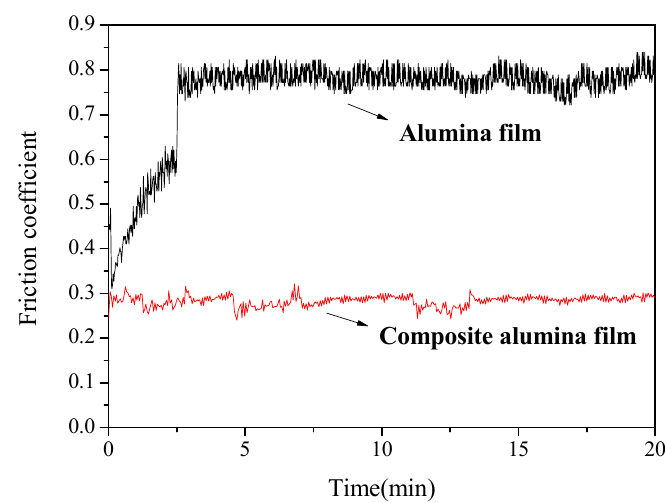
Figure 7. Friction coefficient of the composite alumina film and alumina film.